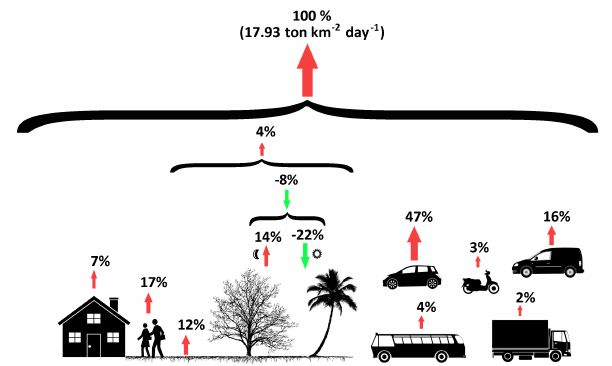
Fig. 3. Partitioning of weekday CO 2 exchange in the low-rise res- idential neighbourhood of Telok Kurau, Singapore, according to emission sources (red arrows) and sinks (green arrows) calculated from direct EC flux measurements and bottom-up approaches. Ve- hicular traffic is the main contributor of CO 2 to the atmosphere: pas- senger cars (47%), motorcycles (3%), commercial vehicles (16%), transit buses (4%) and trucks (2%) contribute a total of 72%. Other emission sources are in descending order of importance: human respiration (17%), soil respiration (12%) and household emissions (7%) for a total of 36%. Aboveground vegetation sequesters 22% of total emissions during daylight hours, but releases 14% at night resulting in a CO 2 uptake of 8%. When soil respiration is added to the aboveground flux, the biogenic component becomes a net source amounting to 4% to the total daily CO 2